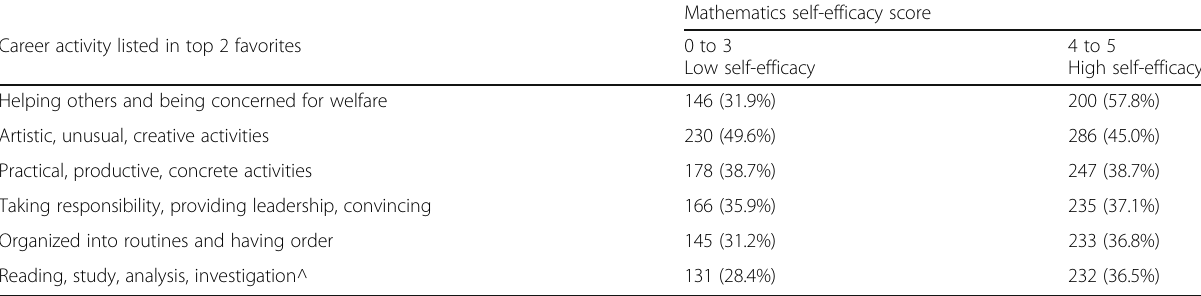
Mathematics self-efficacy score